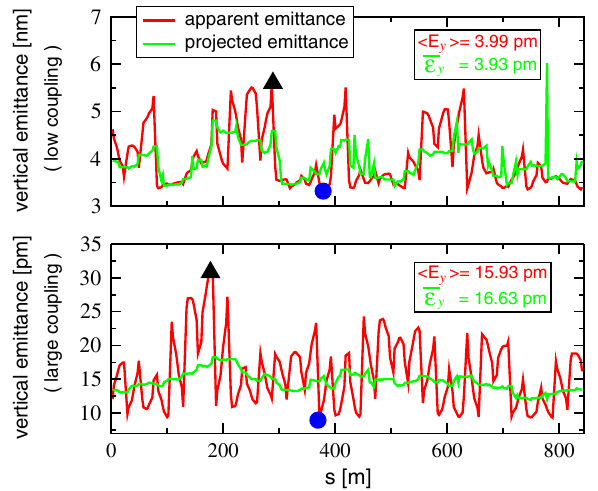
(green) from y would overesti- y , that on the other hand y